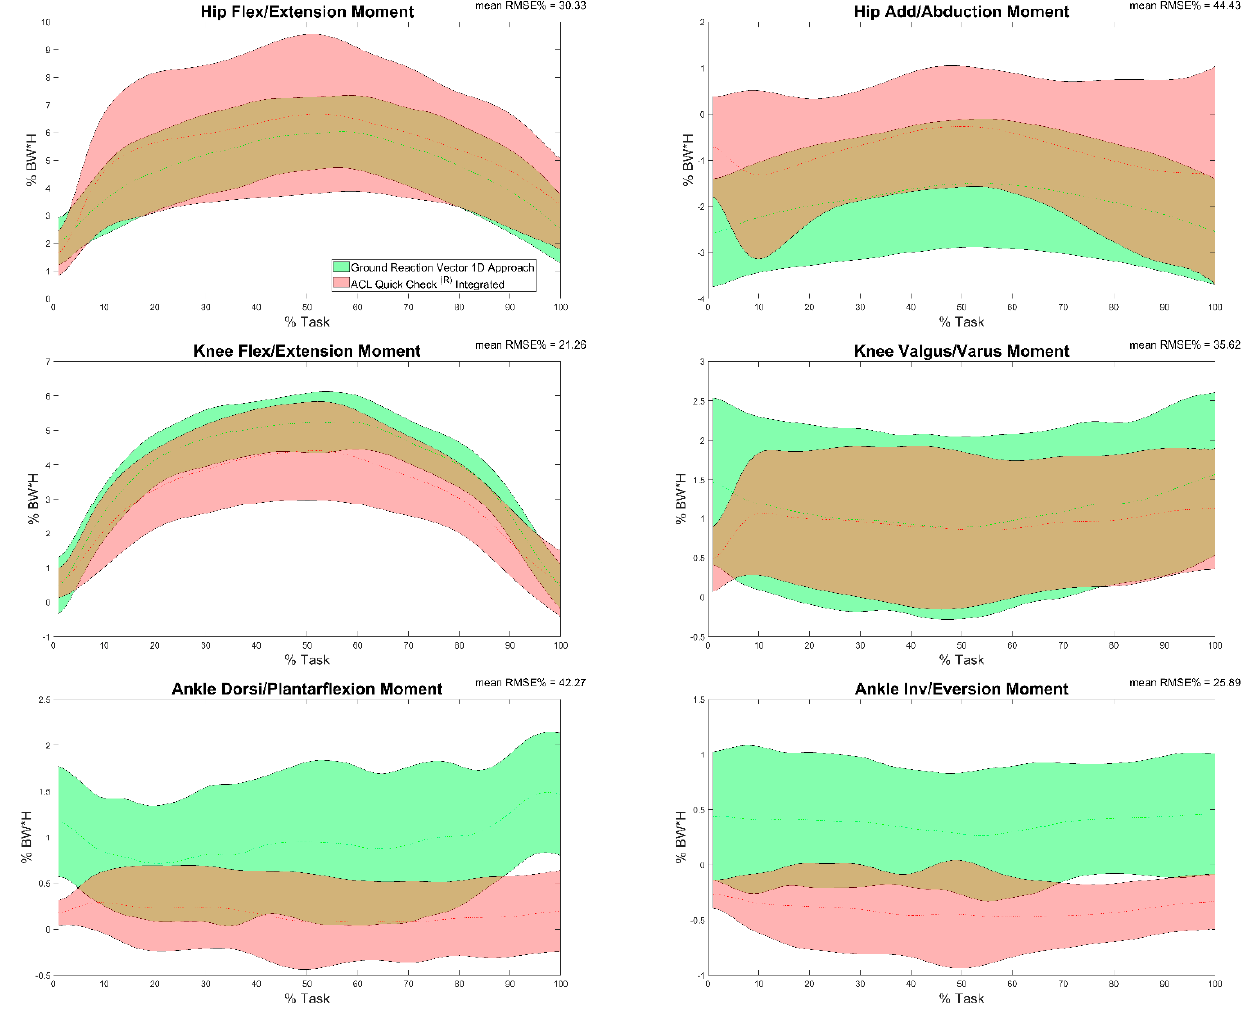
Figure 7. Hip, knee and ankle adduction/abduction and flexion/extension moments during the task calculated through moment arm 1D approach (green) and through ACL Quick Check ® integrated (red) and mean of RMSE% of the comparison between the two. Averages plus and minus one standard deviation are reported as colored bands.